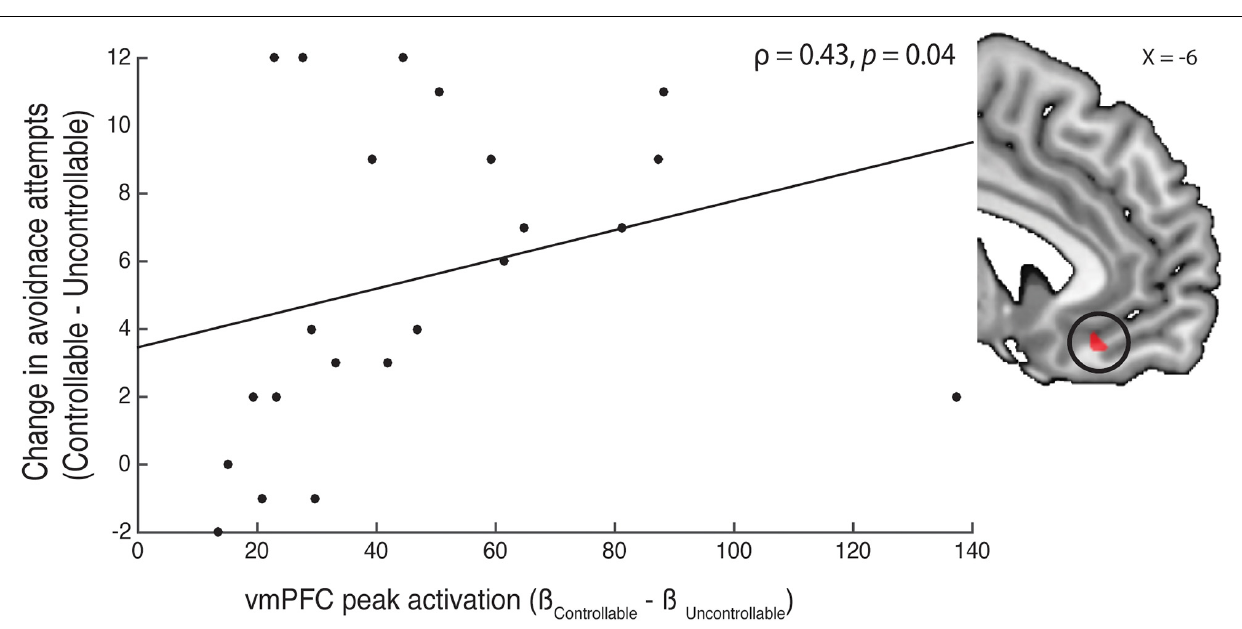
FIGURE 4 | Correlation of avoidance behavior and neural activity. We examined the relationship between vmPFC activity in the controllable — uncontrollable cue contrast and participants’ changes in avoidance behavior between the two phases. Using a functional mask (shown in the right insert) created from the peak coordinate (peak MNI x , y , z = − 6, 32, − 14) reported in Wang and Delgado (2019), we extracted the peak activation and correlated them with participants’ change in avoidance attempts from the controllable to uncontrollable phase. We found that participants with a larger vmPFC peak activation also had a bigger increase in avoidance behavior in the controllable